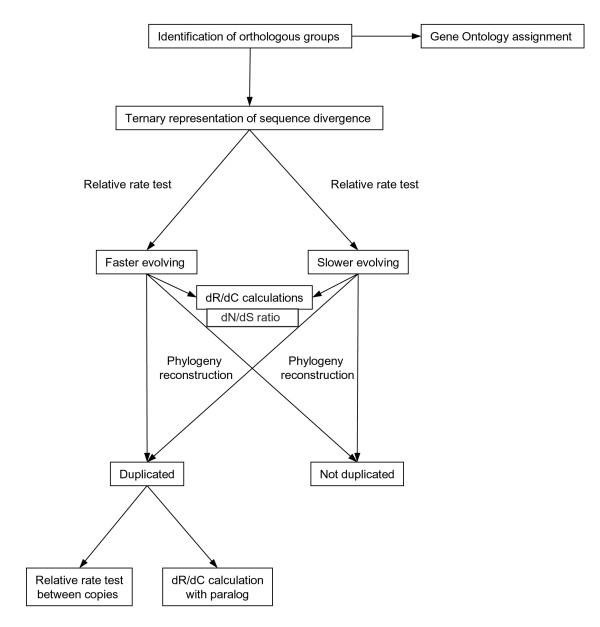
Flowchart of the analysis routine used in this study.